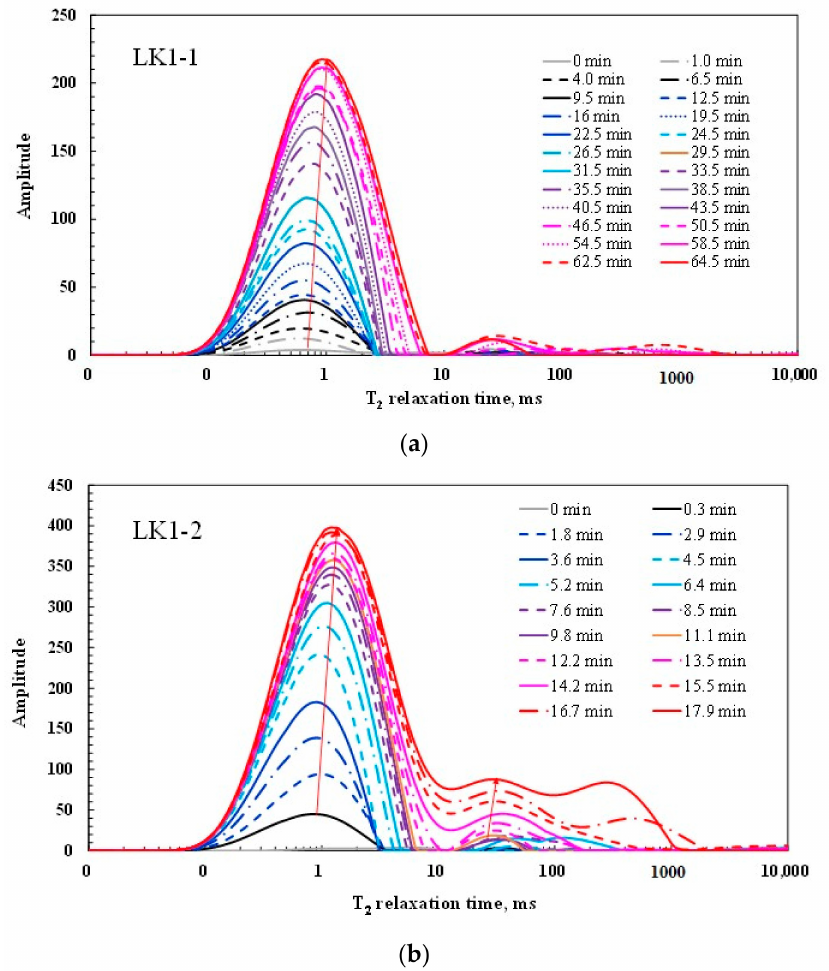
Figure 6. T 2 spectra vs. imbibition of LK formation. ( a ) LK1-1; ( b )